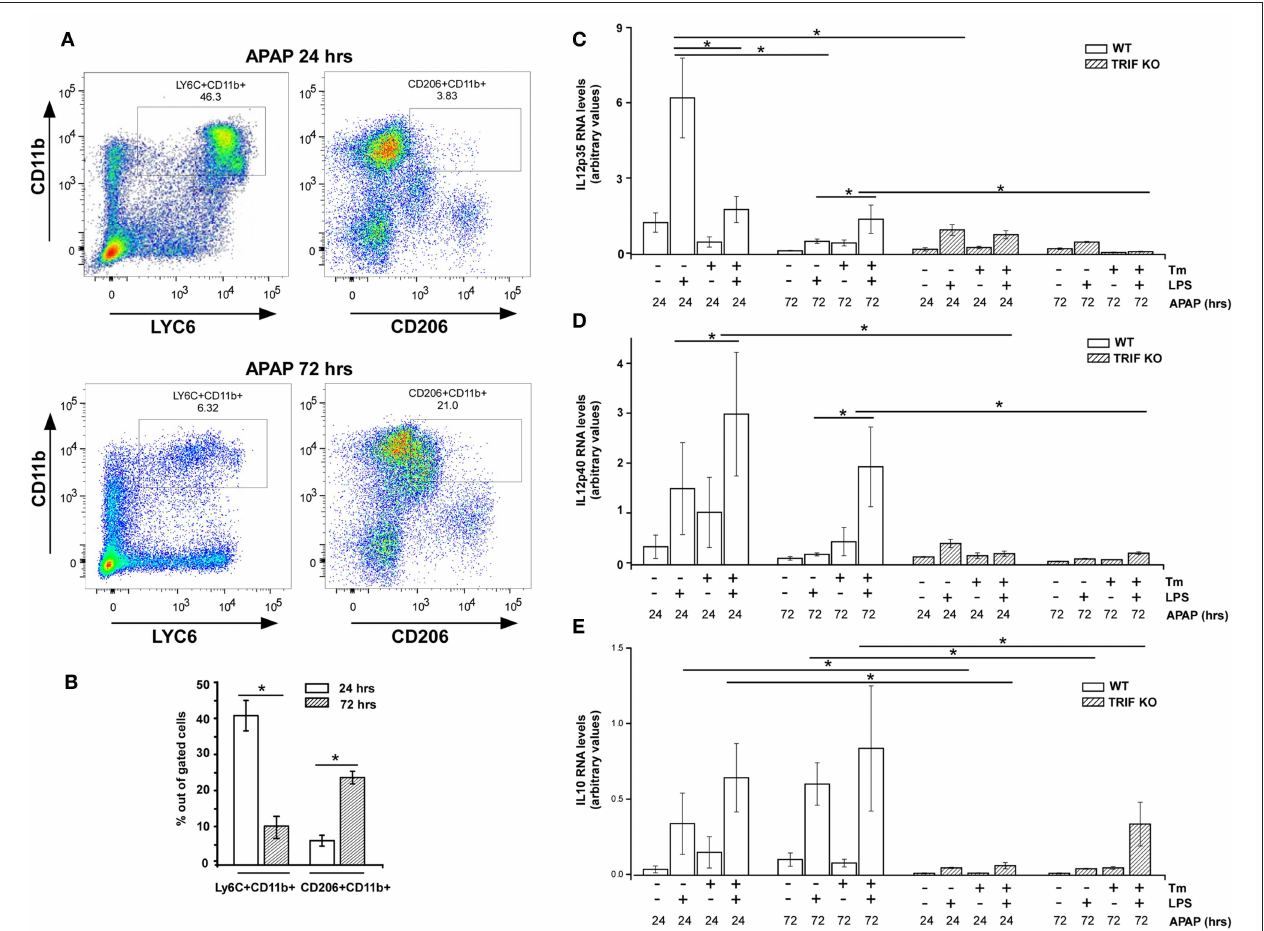
FIGURE 5 | Sensitivity to stress-induced modulation of cytokine expression in infiltrating liver myeloid cells varies over the course of inflammatory response. (A) WT Mice were injected i.p. with APAP (300 mg/kg body weight) for 24 or 72h prior to the isolation of liver non-parenchymal cells. The isolated liver non-parenchymal cells were immunostained for surface CD11b, CD206, and Ly6C and analyzed by flow cytometry. (B) The percentage of LY6C + and CD206 + cells within the gated cell populations ( n = 4). (C–E) WT and TRIF-/- mice were injected i.p. with APAP (300 mg/kg) for 24 or 72h and treated with DMSO or Tm i.p. during the final 18h. Liver CD11b + cells from WT and TRIF-/- mice were isolated using anti-CD11b-PE and MACS magnetic column followed by treatment with or without LPS (100ng/ml) for 3h. Total RNA was prepared and used to determine IL12p35 (C) , IL12p40 (D), and IL10 (E) mRNA levels by real time PCR. Data are presented as the mean ± SD of triplicate experiments for WT ( n = 3 per treatment for each experiments) and duplicate experiments for TRIF-/- mice ( n = 3 per treatment for each experiments). The differences between indicated treatments were evaluated by two way-ANOVA and Turkey’s multiple comparisons test. * p < 0.05 was considered